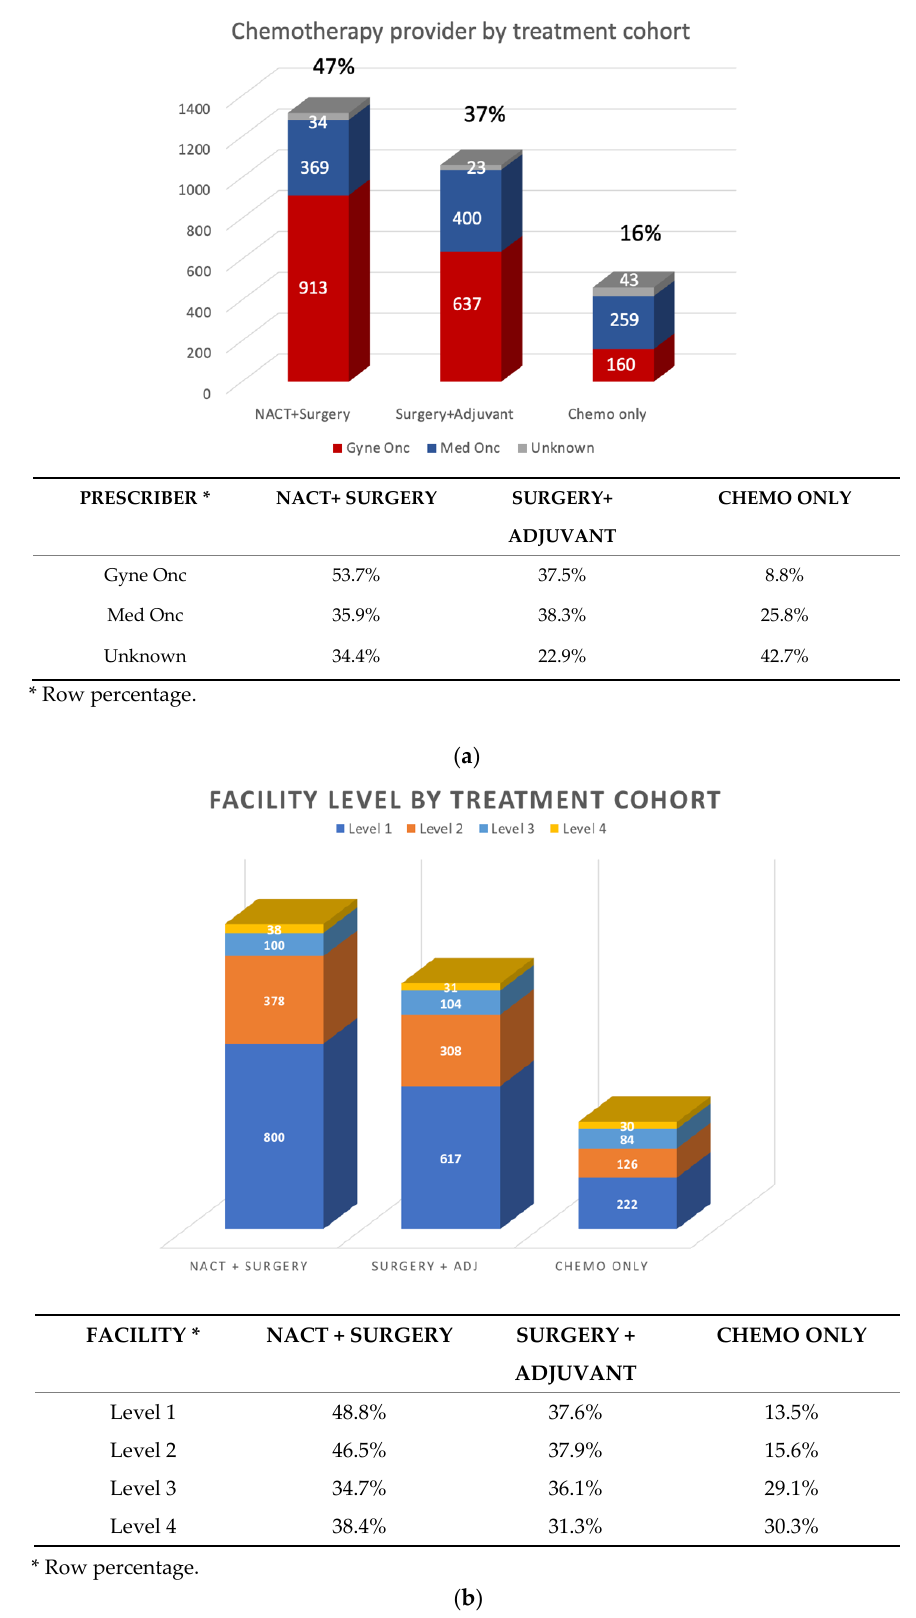
Figure 2. ( a ) Chemotherapy provider by treatment cohort; ( b ) Facility level by treatment cohort. NACT+surgery = neoadjuvant chemotherapy and surgery (A); surgery + Adjuvant = upfront surgery and adjuvant chemotherapy (B); chemo only = chemotherapy only